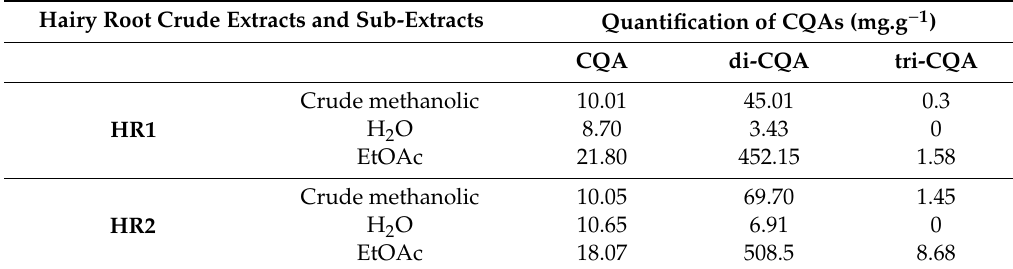
Table 1. Quantification of CQAs (mg.g − 1 of dry extracts) in crude extracts and sub-extracts of elicitated and non elicitated hairy root